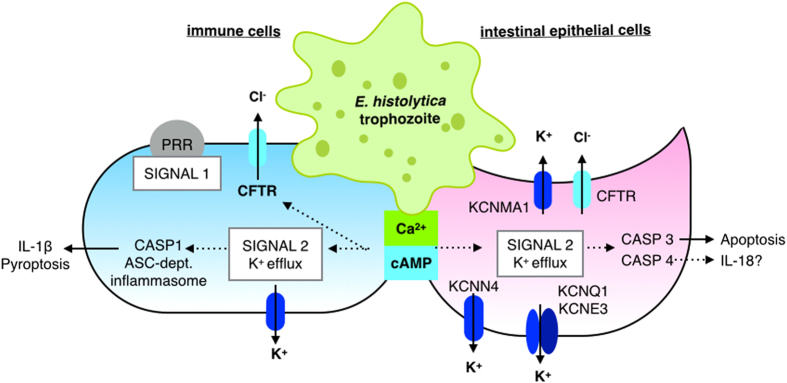
Model for E. histolytica activation of K+ channels in host cell killing.In both intestinal epithelial and immune cells, E. histolytica triggers increased intracellular Ca2+ and cAMP. In an intestinal epithelial cell (purple cell on the right), Cl− efflux is mediated by apical Cftr, while K+ efflux occurs at both apical and basolateral surfaces. Increased intracellular Ca2+ activates large conductance K+ channels in the apical and basolateral membranes. Cl− efflux may be activated directly by increased intracellular Ca2+ and/or cAMP or may occur secondarily to K+ efflux to regulate cellular charge polarization. As K+ and Cl− efflux occurs, water and intracellular ion concentrations fall which causes cells to shrink. Cell shrinkage and decreased intracellular K+ trigger caspase activation. In intestinal epithelial cells it appears that caspase-3 is activated leading to apoptotic death. In macrophages (blue cell on the left), decreased cytosolic K+ concentration mediated caspase-1 activation leading to inflammasome activation, IL-1β secretion and pyroptotic cell death.